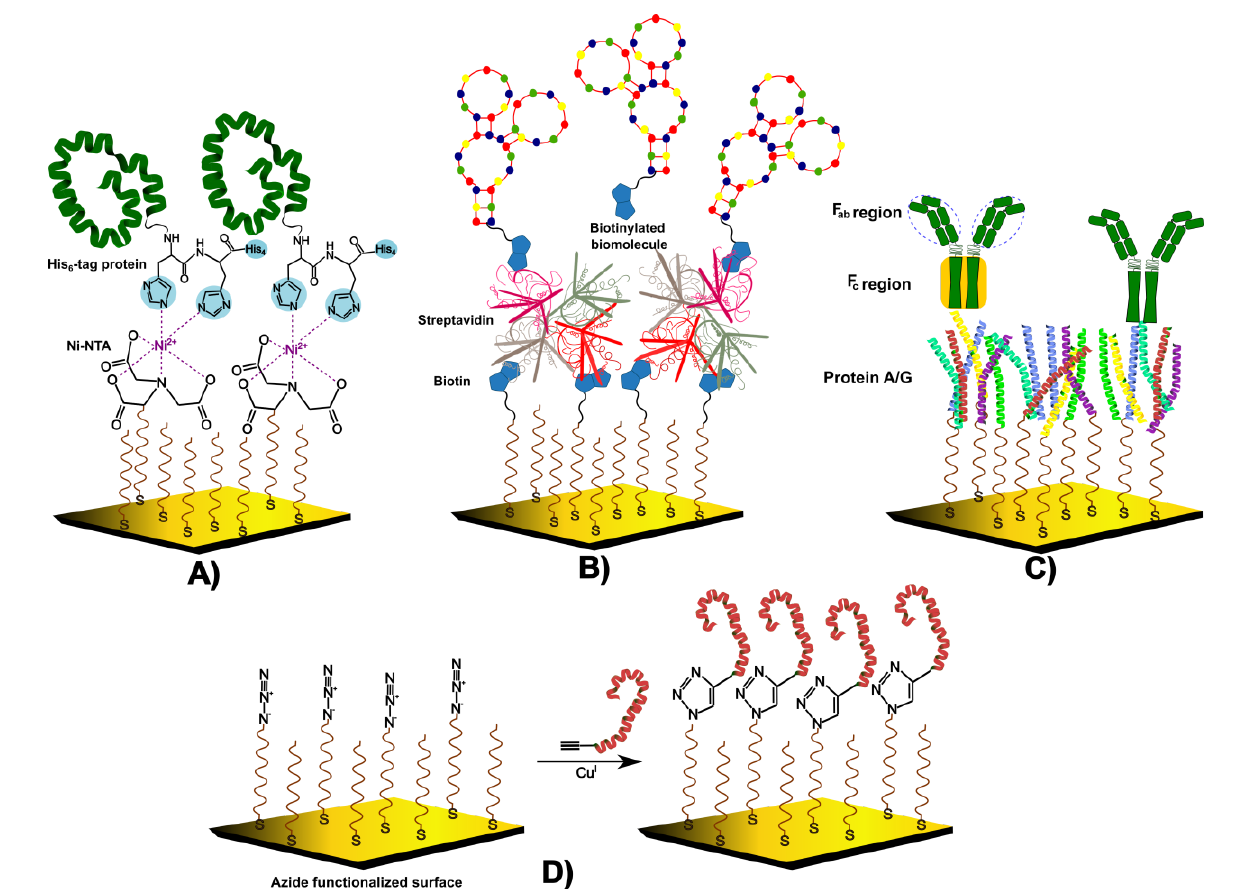
Figure 4. Strategies for oriented immobilization: ( A ) surface-immobilized NTA reacts with Ni 2+ . In the second step, the chelate complex binds the His 6 -tag protein; ( B ) biotin – streptavidin interaction between the immobilized streptavidin and biotinylated aptamer; ( C ) antibody immobilization on the SPR chip via protein A/G, which specifically binds to the F c antibody region; ( D ) click chemistry: the surface is modified with azide groups that subsequently react with the alkyne modified ligand.